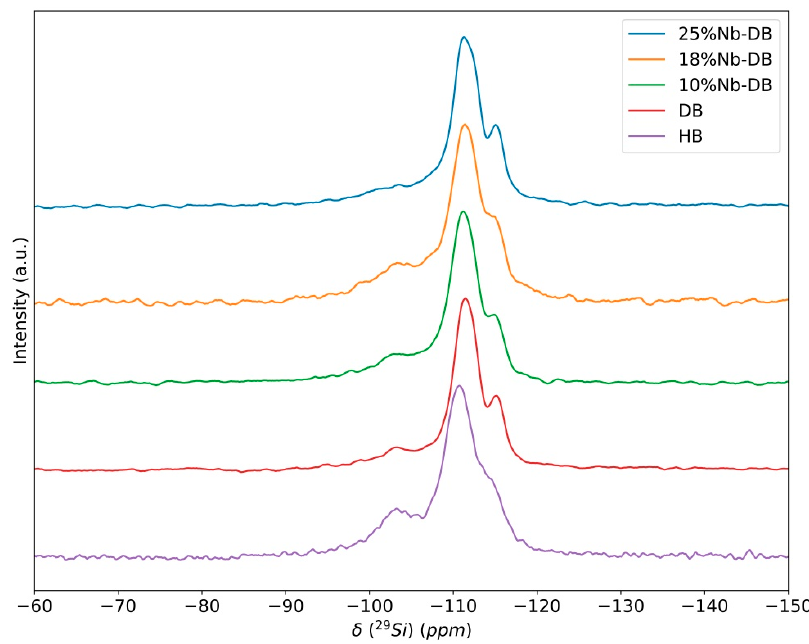
Figure 5. 29 Si magic angle spinning nuclear magnetic resonance (MAS NMR) spectra of the